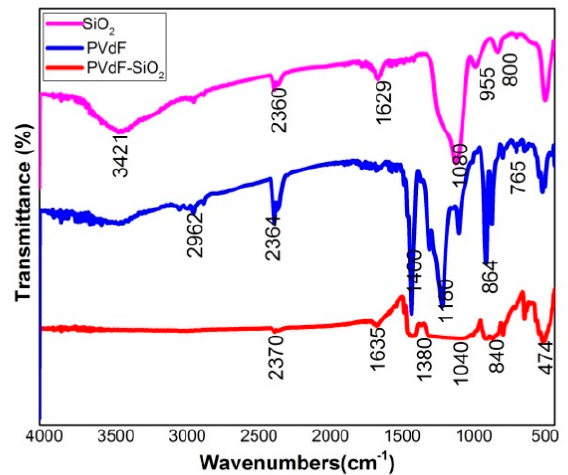
Figure 2. FT-IR spectrum of as prepared PVdF-SiO 2 membrane, pure PVdF, and SiO 2 .